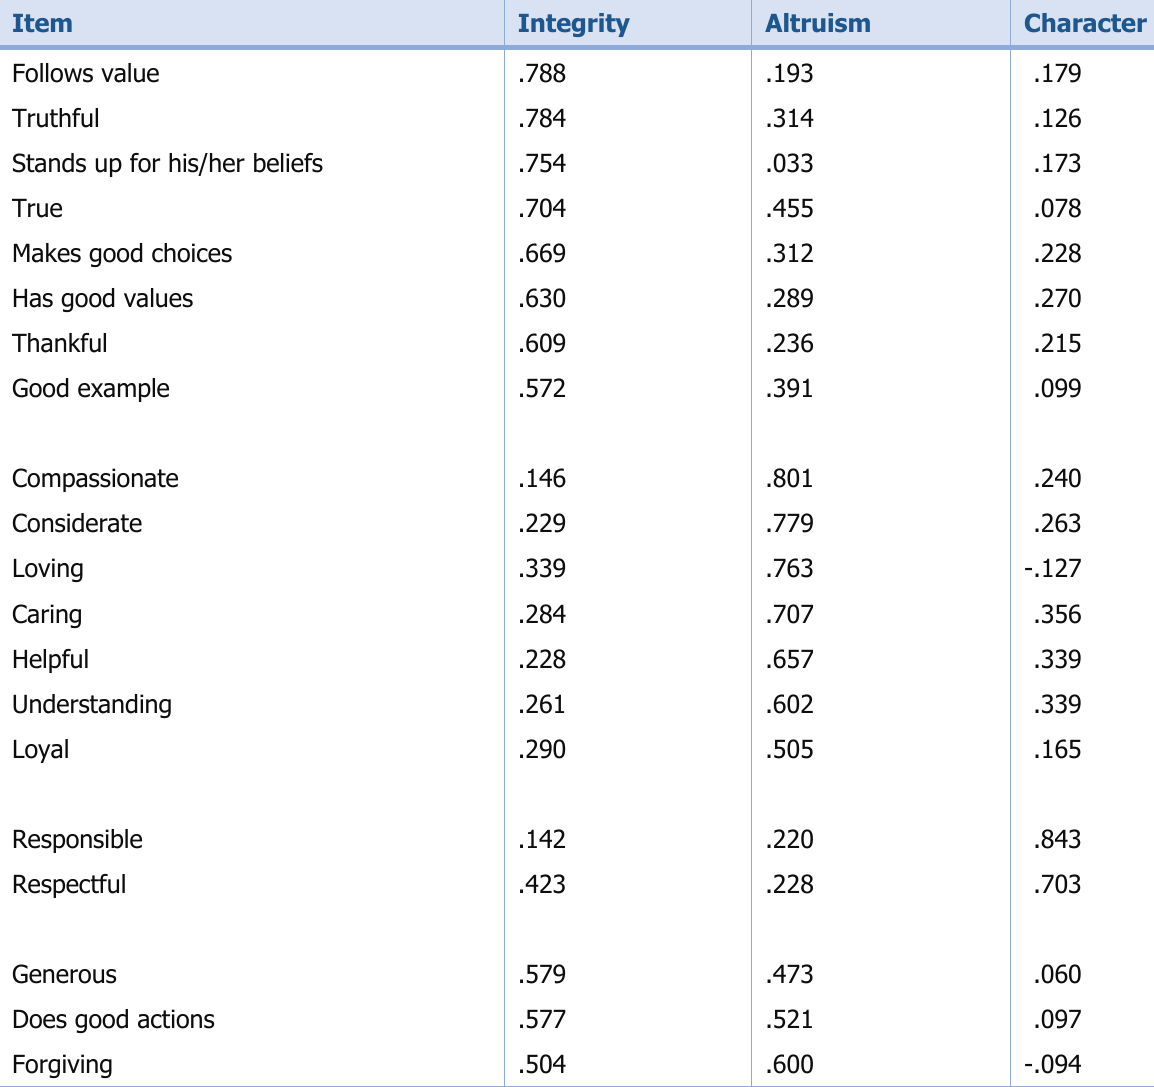
Table 2. Principle Component Analysis of Posttest Data From the Moral Ideal Self